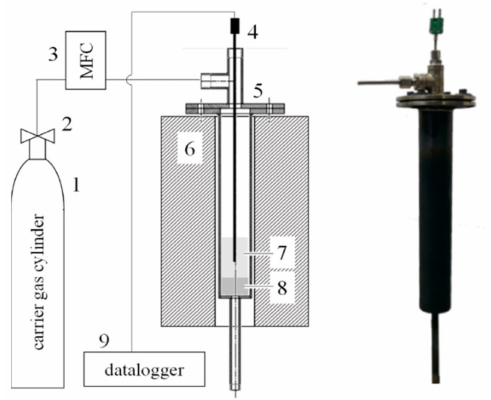
Figure 1. Fixed-bed reactor apparatus for thermal degradation tests. 1. Carrier gas cylinder (N 2 or CO 2 depending on the test). 2. Pressure reducer. 3. Mass flow controller. 4. K-type